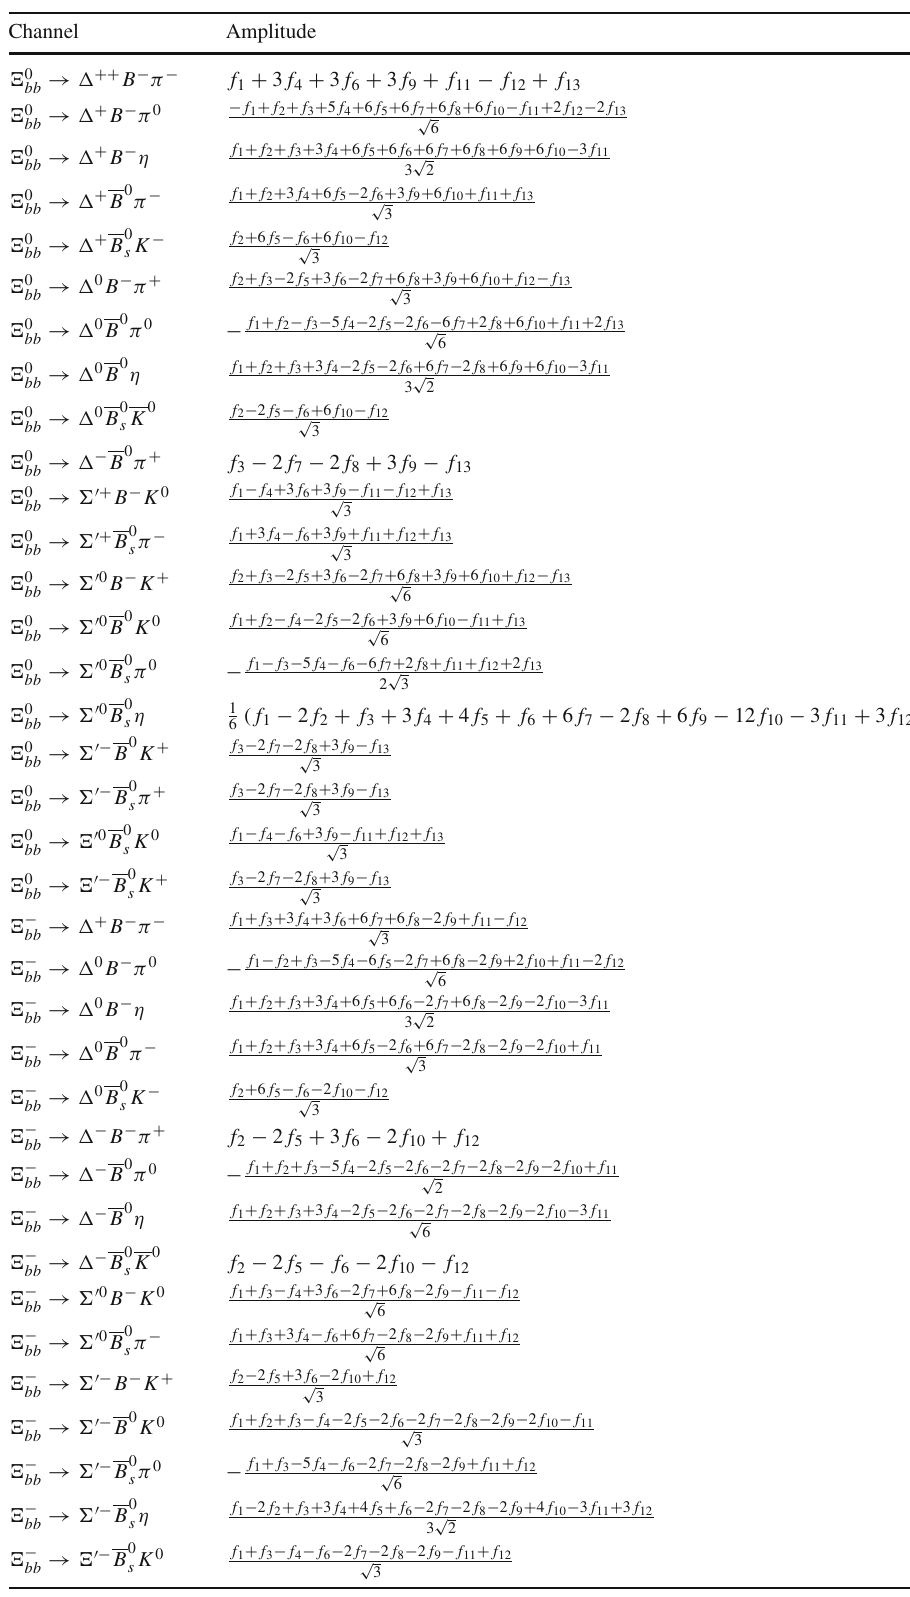
Table 32 Doubly bottom baryon decays (induced by the b → d transition) into a bottom meson, a light baryon(10) and a light meson